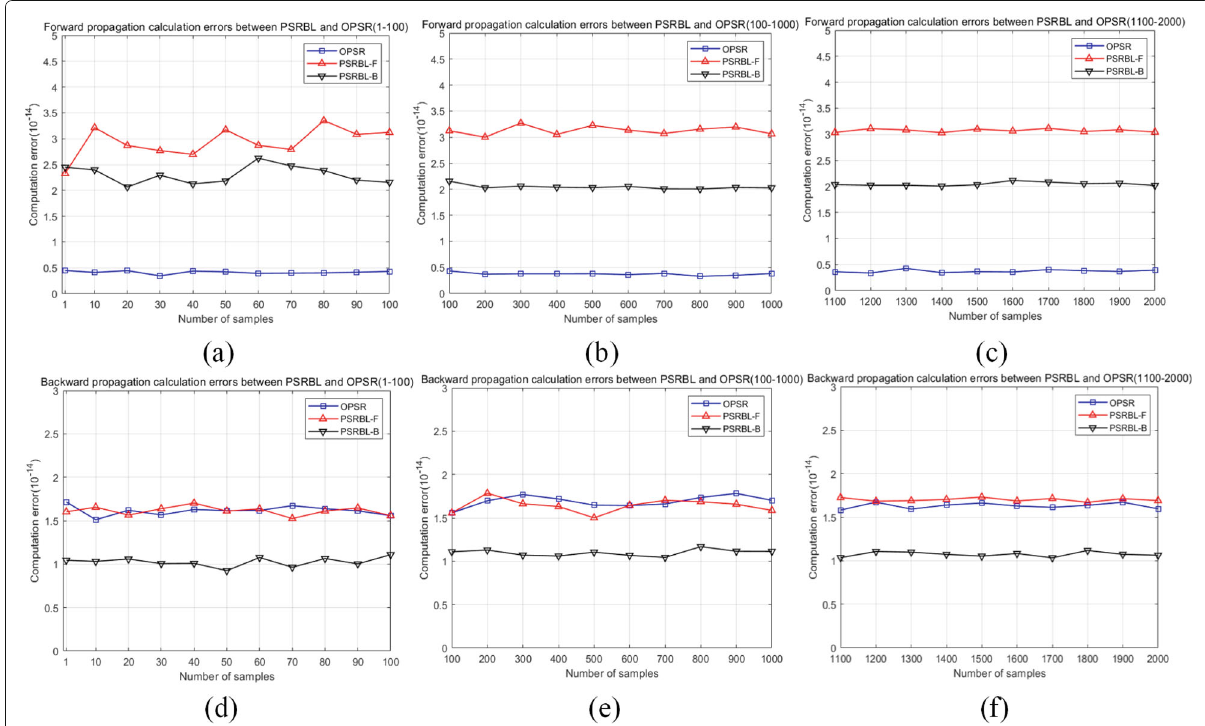
Fig. 4 The computation errors of forward propagation and backward propagation addition protocol and the secure multiplication proto- col. On the other hand, all output vectors of the forget gate, the input gate and the output gate are calculated by SPSigmoid ( x ) and SPTanh ( x ) . Since the security of the secure addition protocol and the secure multiplication protocol has been demonstrated in [14], the processes of forward propagation and back propagation are secure.